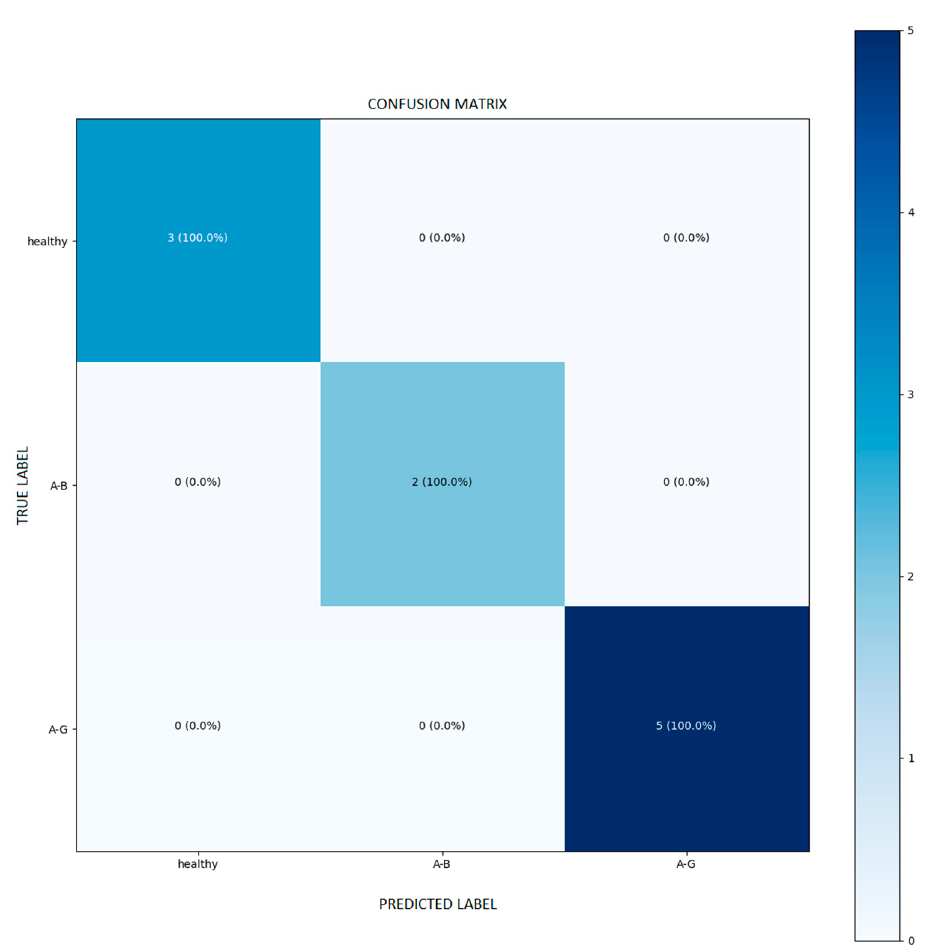
Figure 11. Confusion matrix of the model.